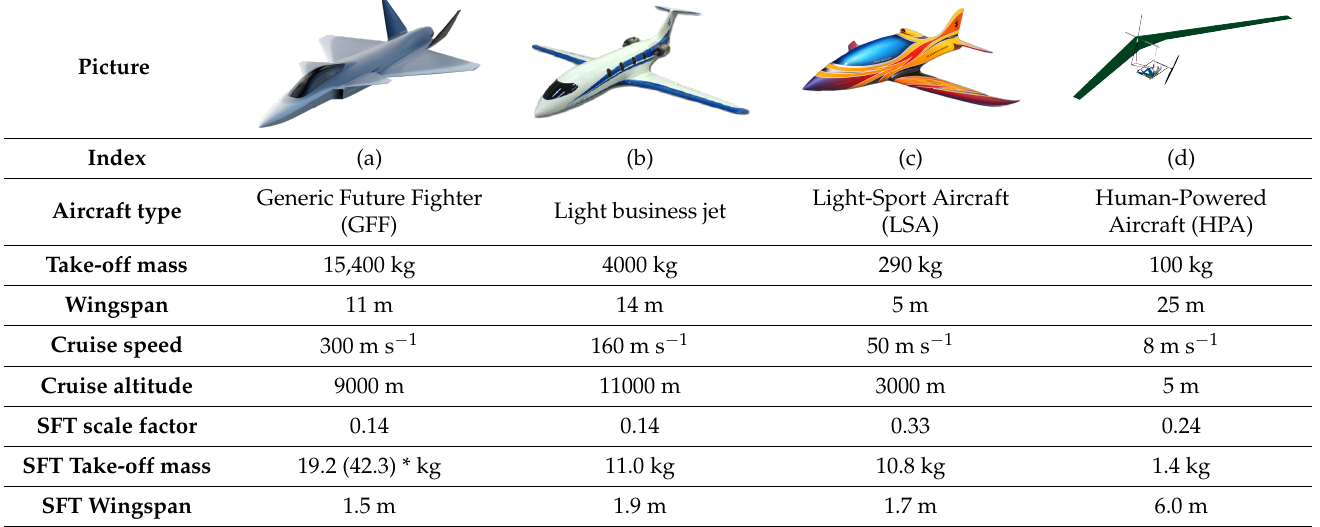
Table 4. Full-scale characteristics of four aircraft concepts used to illustrate the scaling limitations and possibilities. Linköping University has manufactured and flown a subscale model of each concept. * The mass in parenthesis indicates the mass that the scaled GFF should fly at to fulfil dynamic